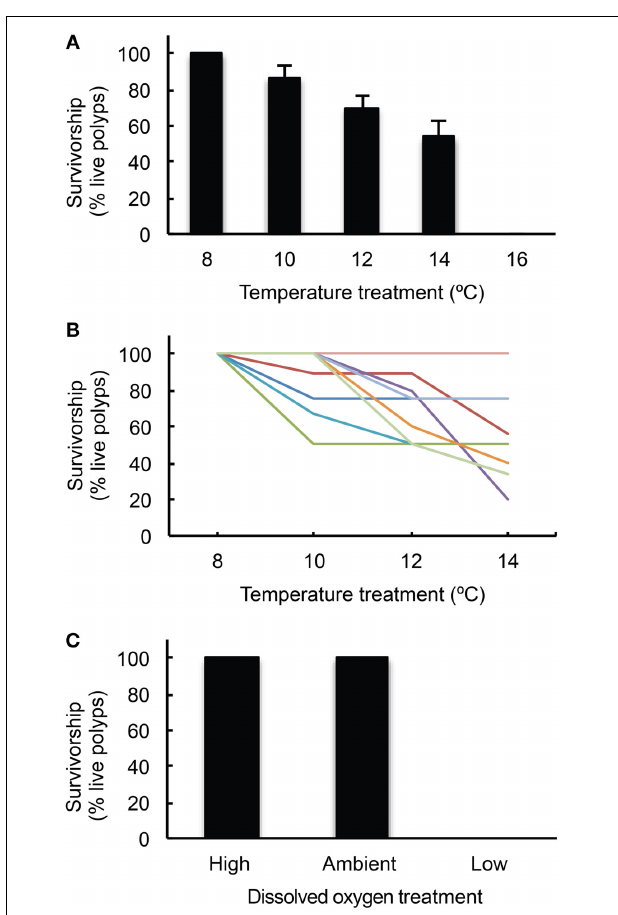
FIGURE 3 | L. pertusa survivorship responses. (A) Mean ± SE ( n = 9) cumulative survivorship of L. pertusa from temperature treatments in the warming experiment; (B) Cumulative survivorship ∗ of individual L. pertusa genets in the warming experiment where each color indicates a unique genotype; (C) Mean ± SE ( n = 9) cumulative survivorship of L. pertusa from dissolved oxygen treatments in the deoxygenation experiment. *Note that in the 14 ◦ C experiment, all corals died during the recovery phase in the maintenance aquaria. It is unclear if this was due to a delayed onset of stress from the 14 ◦ C treatment or by accumulated stress from the prior temperature experiments (8, 10, and 12 ◦